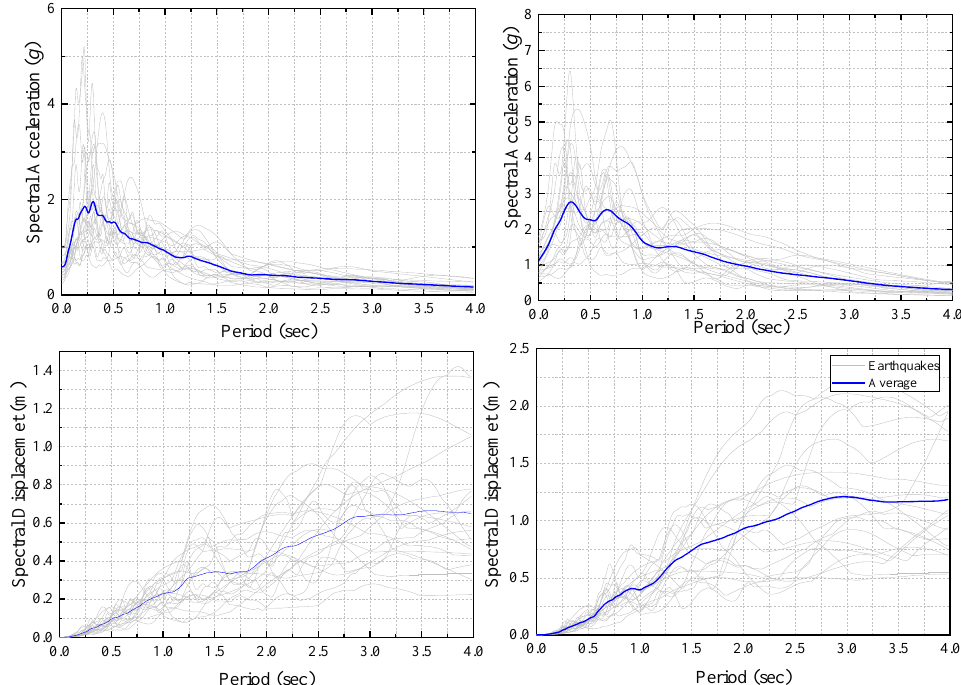
Figure 3. Response spectra of the sets of DBE and MCE earthquake ground motions.